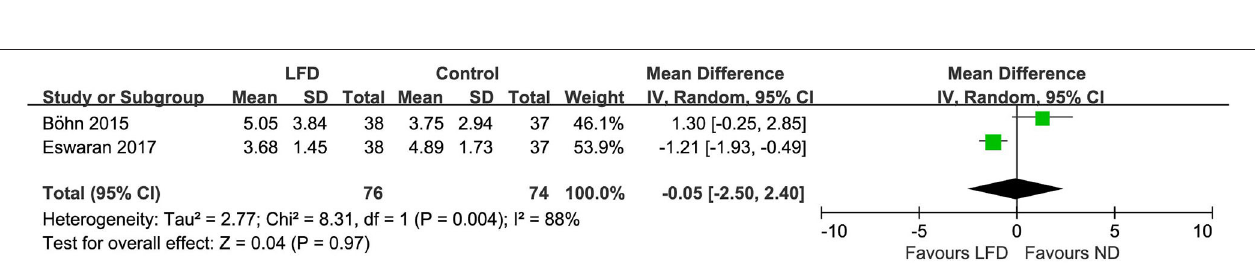
FIGURE 8 | Pooled mean difference for depression score based on the hospital anxiety and depression scale. LFD, low-FODMAP diet; ND, normal diet.